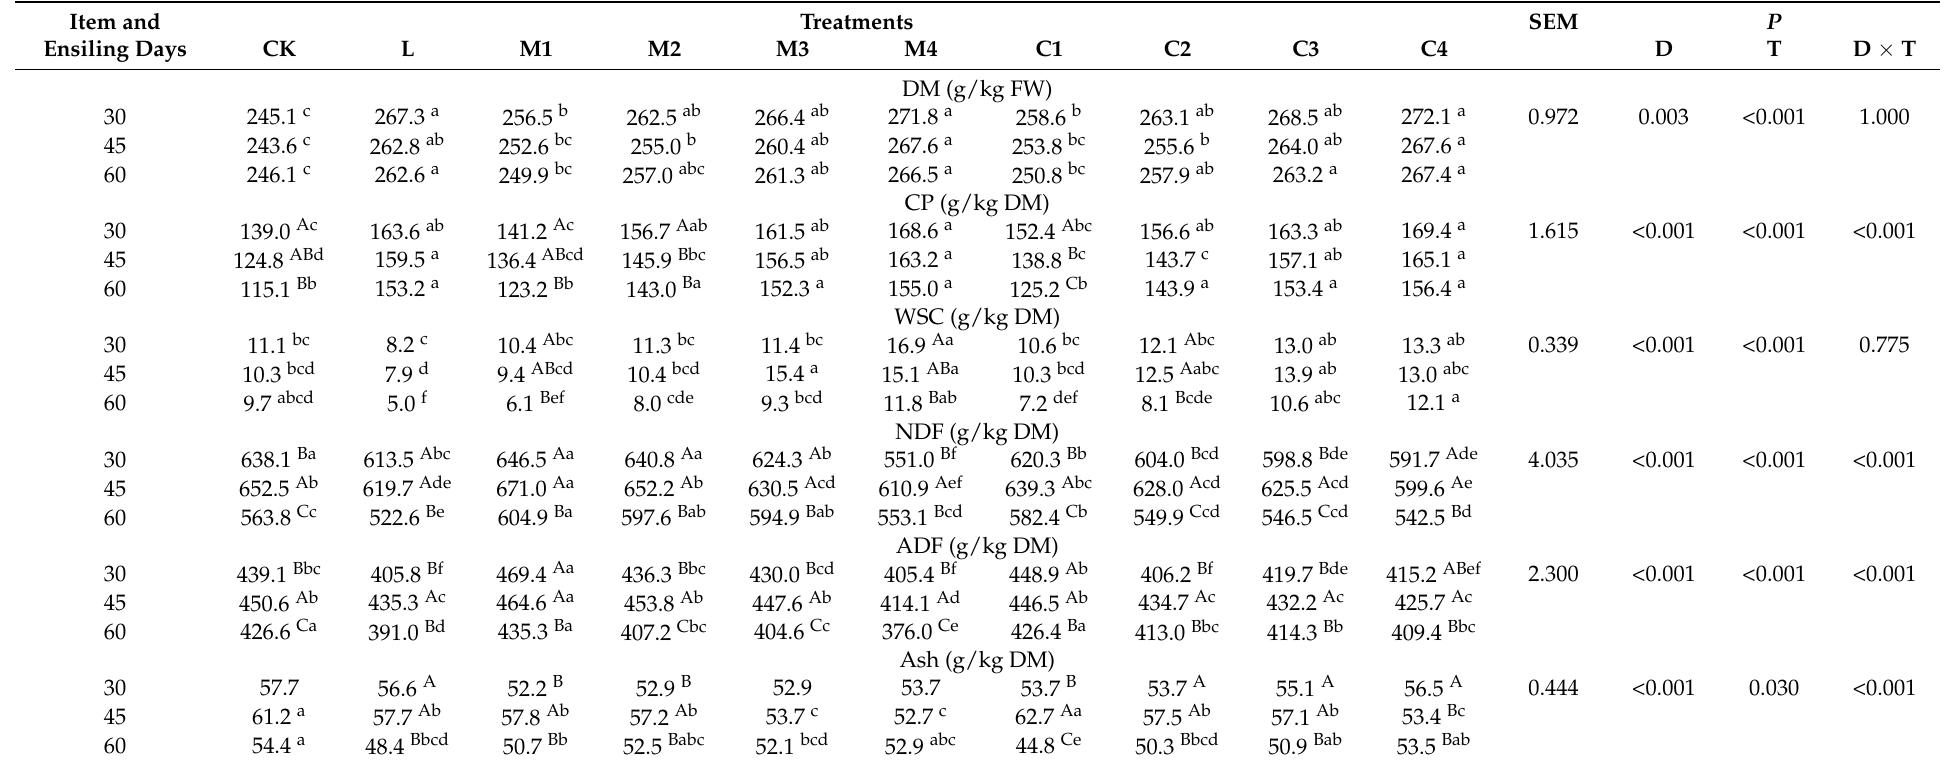
Table 1. Effect of ensiling time, L, and organic acids on nutritional components of Chamaecrista rotundifolia